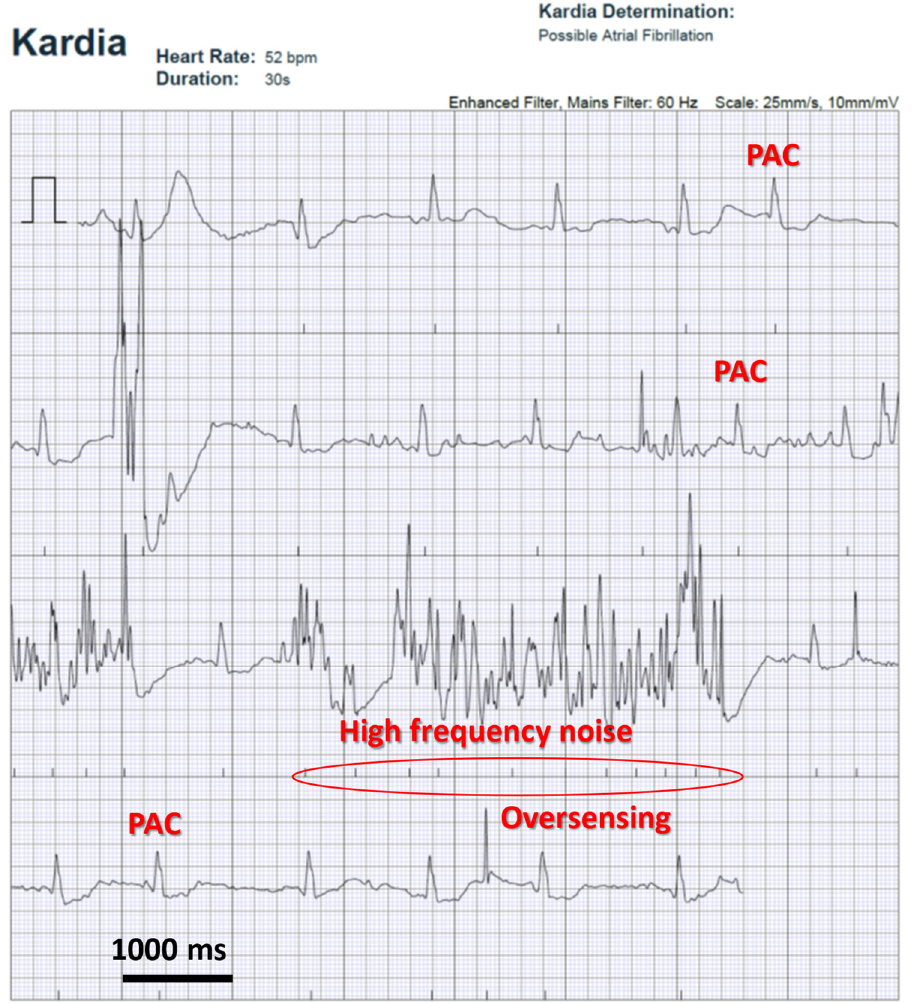
Figure 2. Electrocardiographic recording of heart activity with a commercial heart rate monitor (AliveCor Kardia). Inappropriate detection of high frequency noise led to oversensing and incorrect determination of rhythm (atrial fibrillation)—the patient is in normal sinus rhythm, with frequent PACs (premature atrial contraction—a benign cardiac rhythm abnormality).